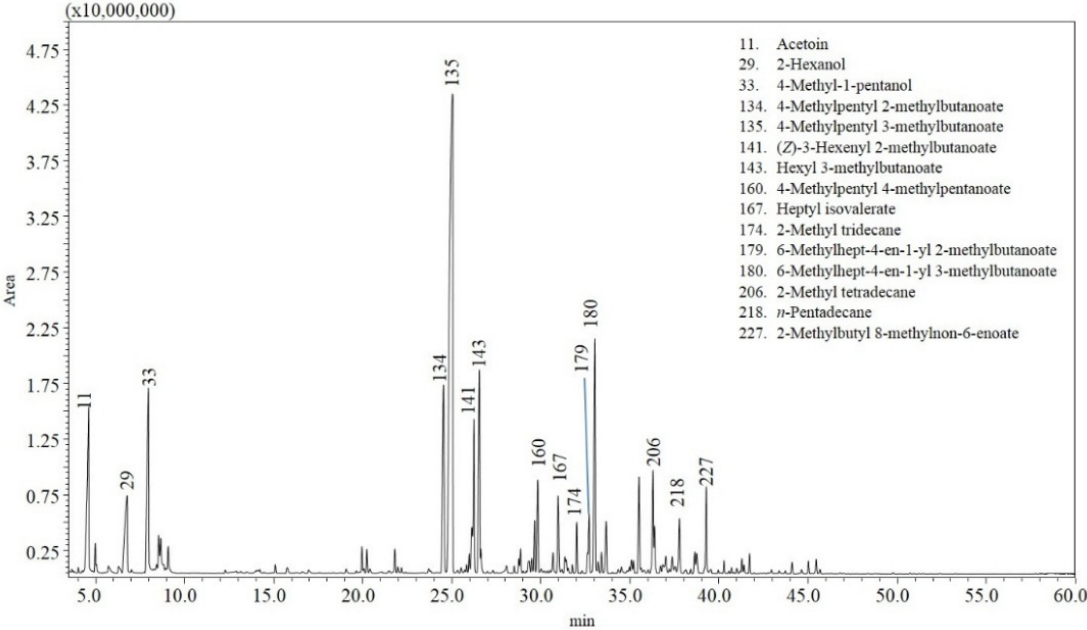
Figure 1. GC ‐ MS analysis of the volatile profile for sample 1 ( C. chinense —Naga Morich). Figure 1. GC-MS analysis of the volatile profile for sample 1 ( C. chinense —Naga